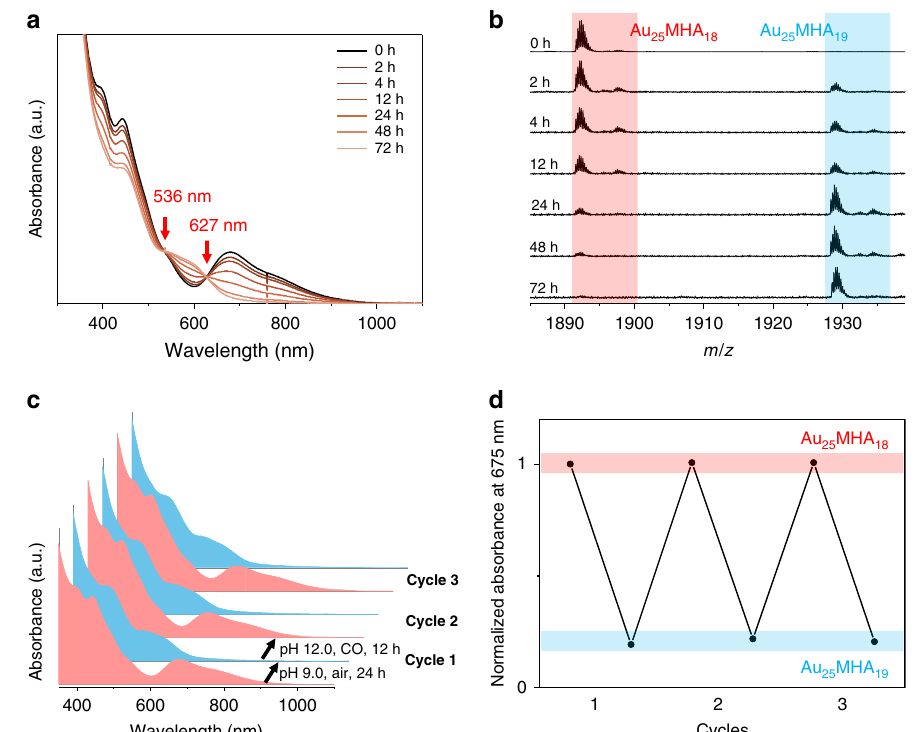
Fig. 4 Interconversion process. a Time-course UV-Vis absorption spectra and b ESI-MS spectra in the transformation from [Au 25 MHA 18 ] species to [Au 25 MHA 19 ] 0 after introducing excess thiol ligands. c and d show the oxidative etching/reduction cycles between [Au 25 MHA 18 ] – and [Au 25 MHA 19 ] 0 by UV-vis absorption spectra and normalized absorbance at 675 nm in the reversible transformation process,